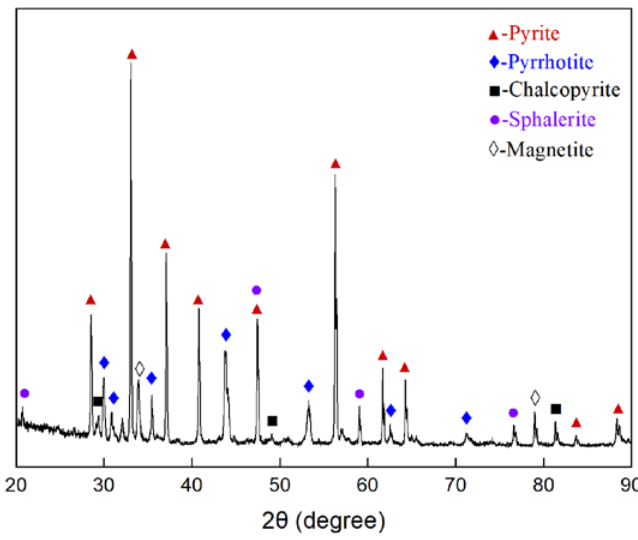
Figure 1. Powder XRD pattern for sulfide concentrate.